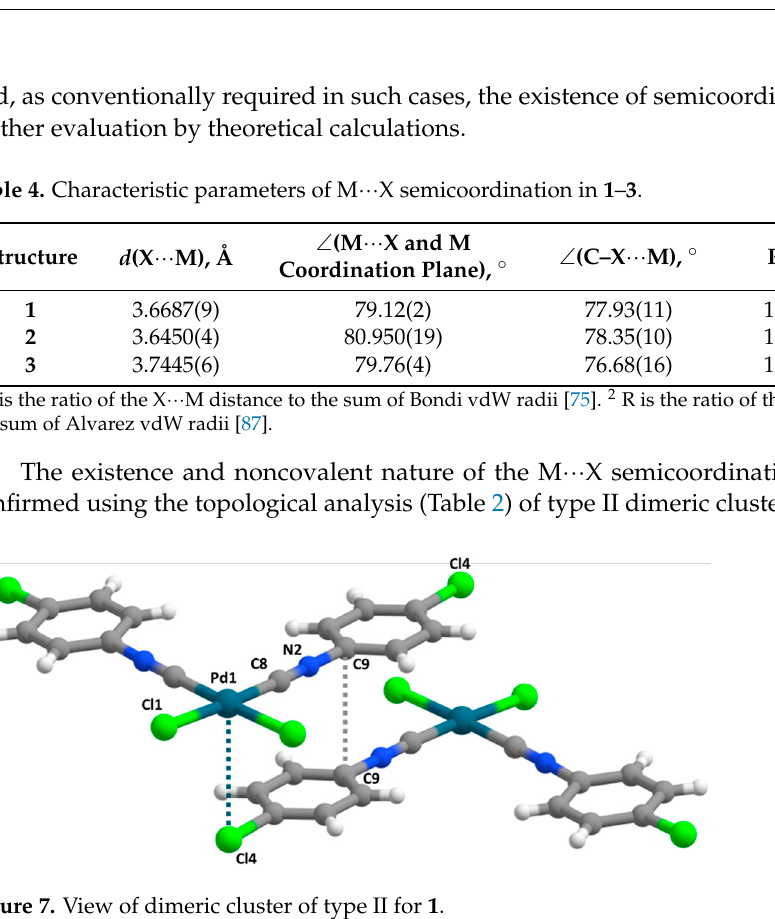
Figure 7. View of dimeric cluster of type II for 1 .